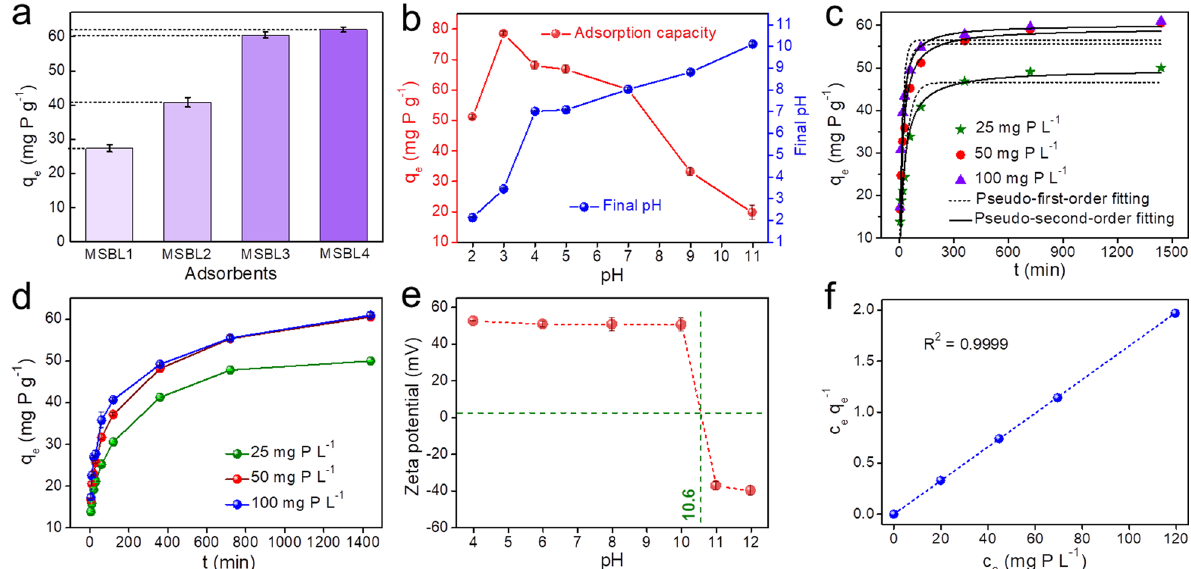
Fig. 4 a Comparison of q e ; b Effect of initial solution pH on P removal of MSBL3; c Sorption kinetic models; d Effect of different P concentrations on q e ; e Zeta potential of MSBL3; f Langmuir model. (dosage of adsorbent: 0.5 g L − 1 ; T: 298